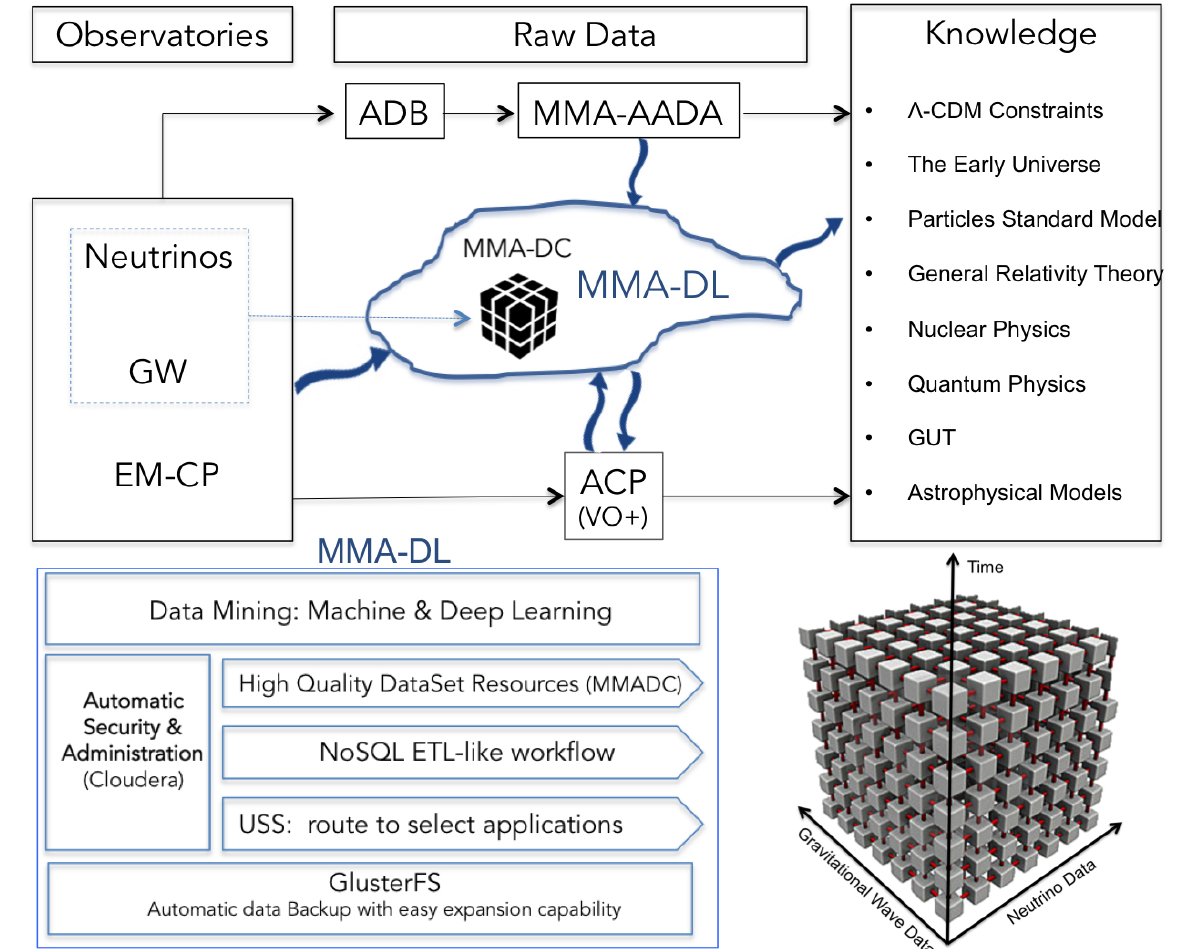
Figure 1. Design of a data lake prototype for MMA with minimally structured raw data within the OLAP paradigm for multidimensional data cubes. The acronyms represent the following abbreviations: ADB for Astronomical Data Base; ADA for Agile Astronomical Data Archive; ACP for Astronomical Cyber Platforms; EM for Electromagnetic Counterparts and GW for Gravitational Waves. Raw data in this figure must be understood within the ETL paradigm reporting all dataset not yet incorporated into a data warehouse-like